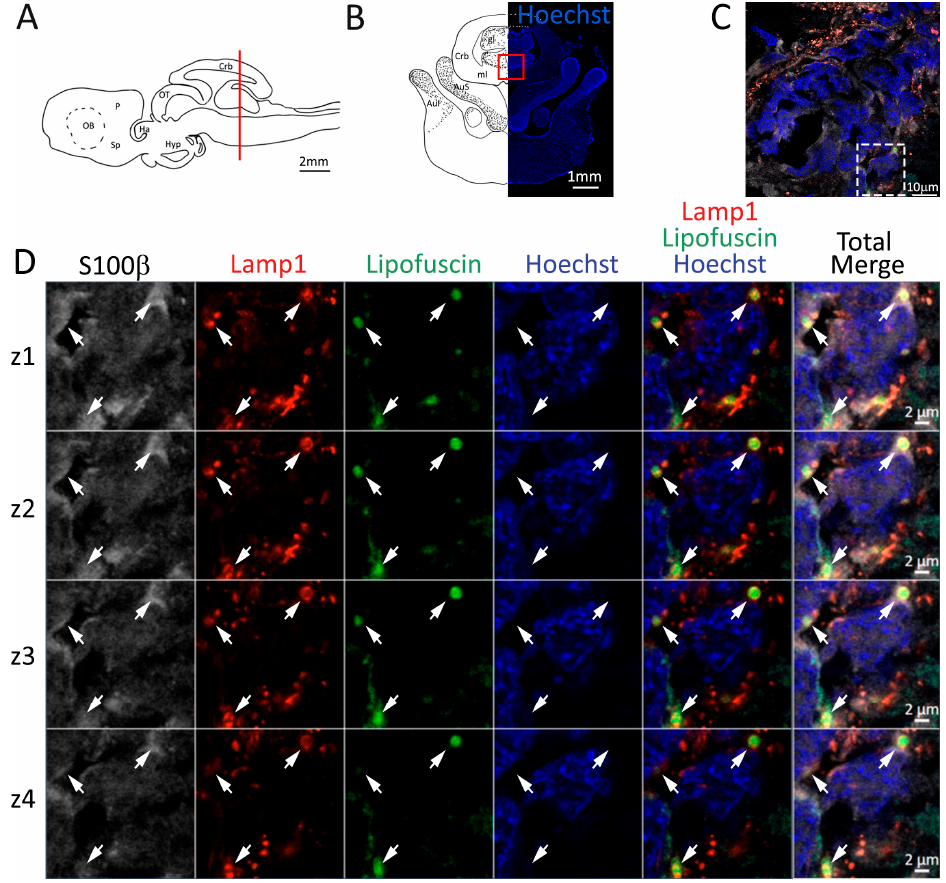
Figure 20. Presence of lipofuscin aggregates inside lysosomes in the cerebellum of S. canicula . ( A ) Sagittal representation of S. canicula brain. The red line indicates the rostro-caudal localization of the section represented in the panel. ( B ) Coronal map of the area imaged. On the right, a real coronal section is stained with Hoechst 33342 to show nuclei distribution; on the left, a cartoon is drawn to indicate anatomical references. Red rectangle identifies the general area from which images are taken. ( C ) Area of the neurogenic niche where magnifications are taken from. ( D ) Lysosomes (Lamp1, red) containing lipofuscin aggregates (green). In the panel, four consecutive z planes are represented (z1–z4) to render the three-dimensionality of the inclusion. Each plane is acquired at 1 μ m step in the z-axis from the previous. Last column represents the overlay of all four channels. White arrows indicate the localization of lysosomes containing lipofuscin.